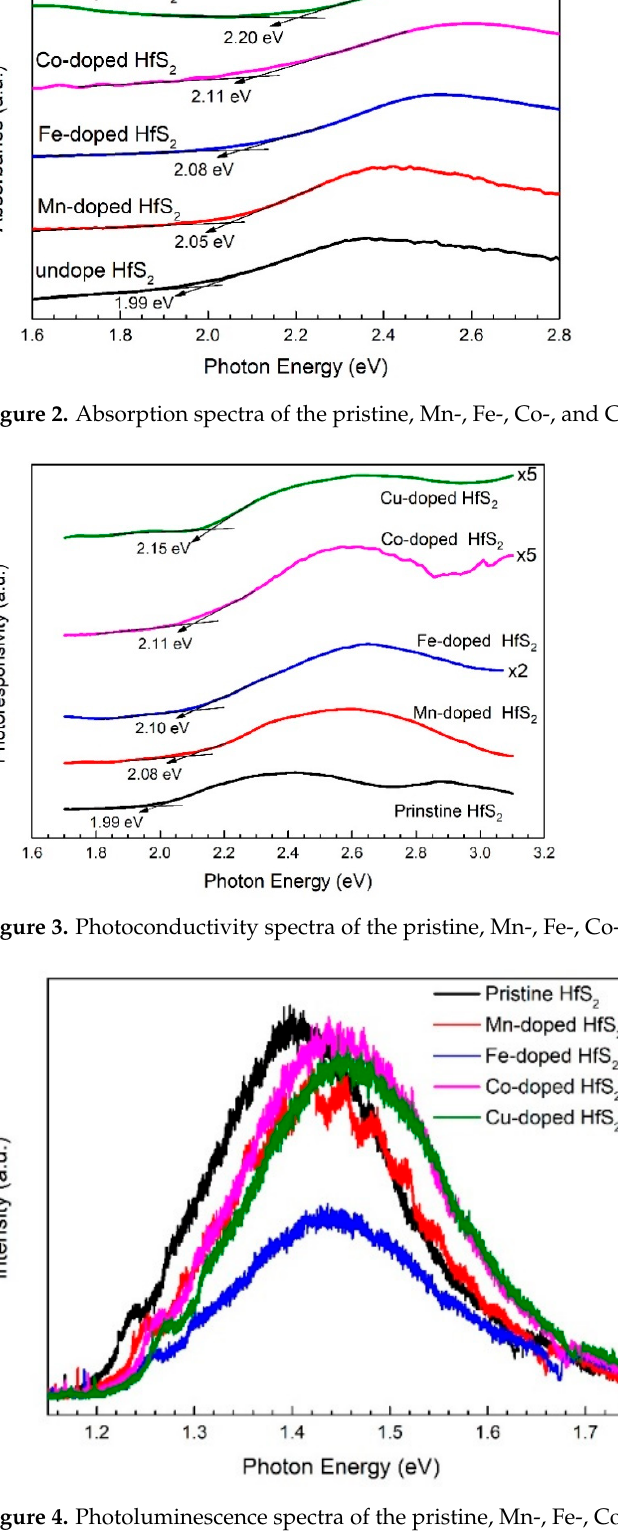
Figure 4. Photoluminescence spectra of the pristine, Mn-, Fe-, Co-, and Cu-doped HfS 2 crystals.